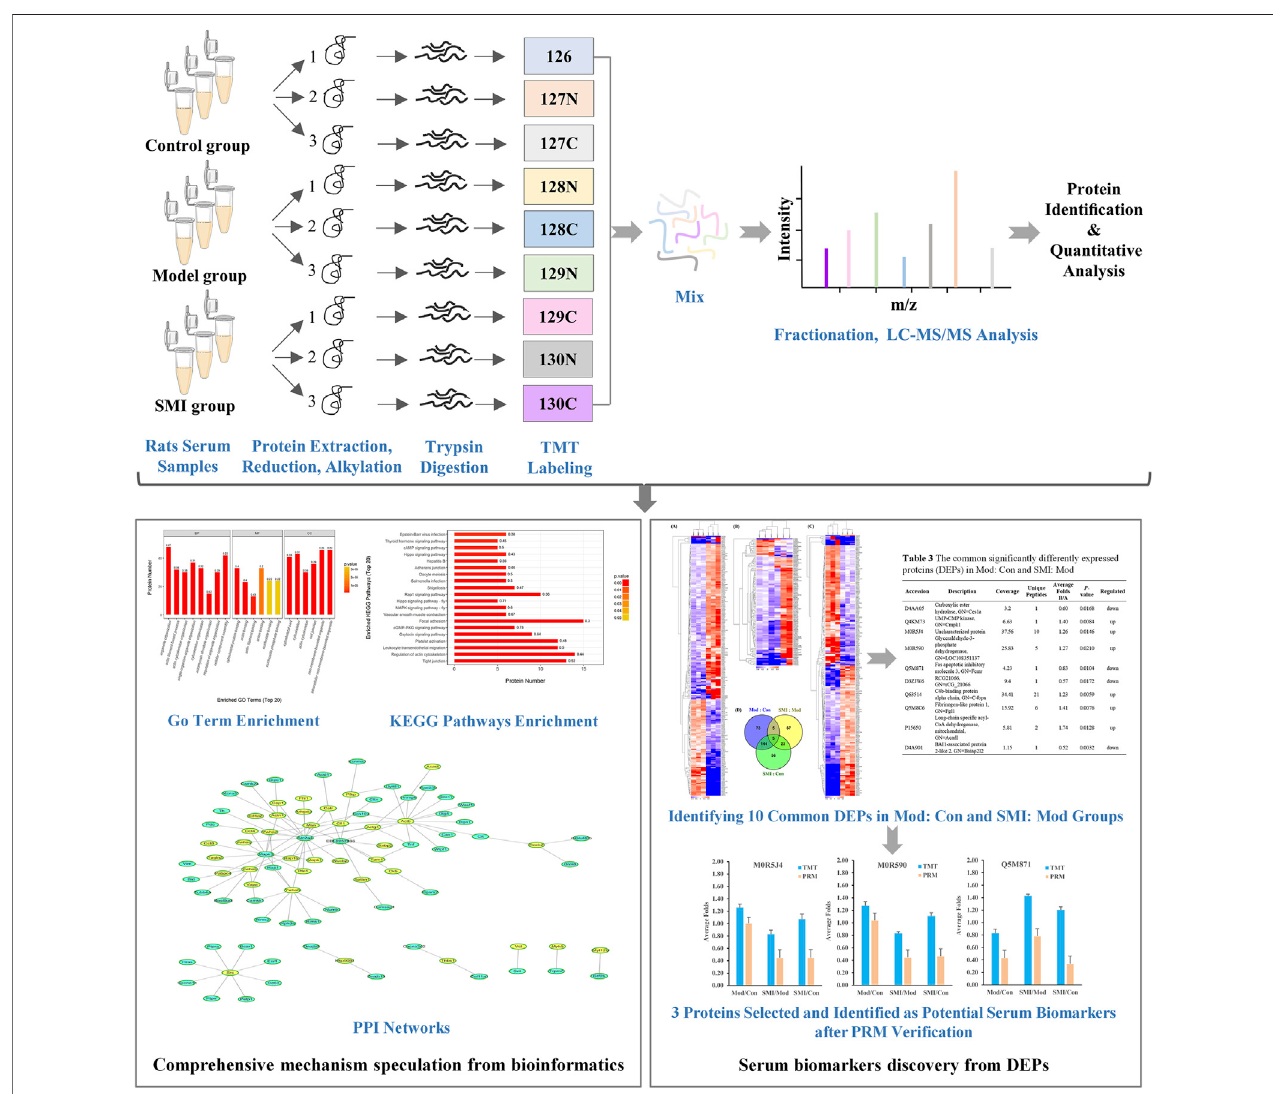
FIGURE 1 | Work fl ow for exploring the comprehensive mechanism and identifying serum biomarkers of SMI ’ s cardioprotective effects.